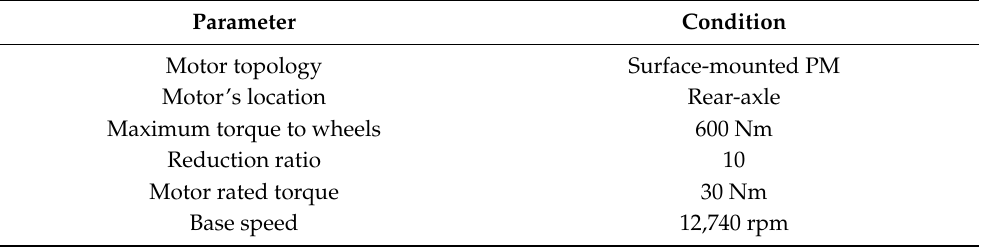
Table 1. Design choices and requirements.